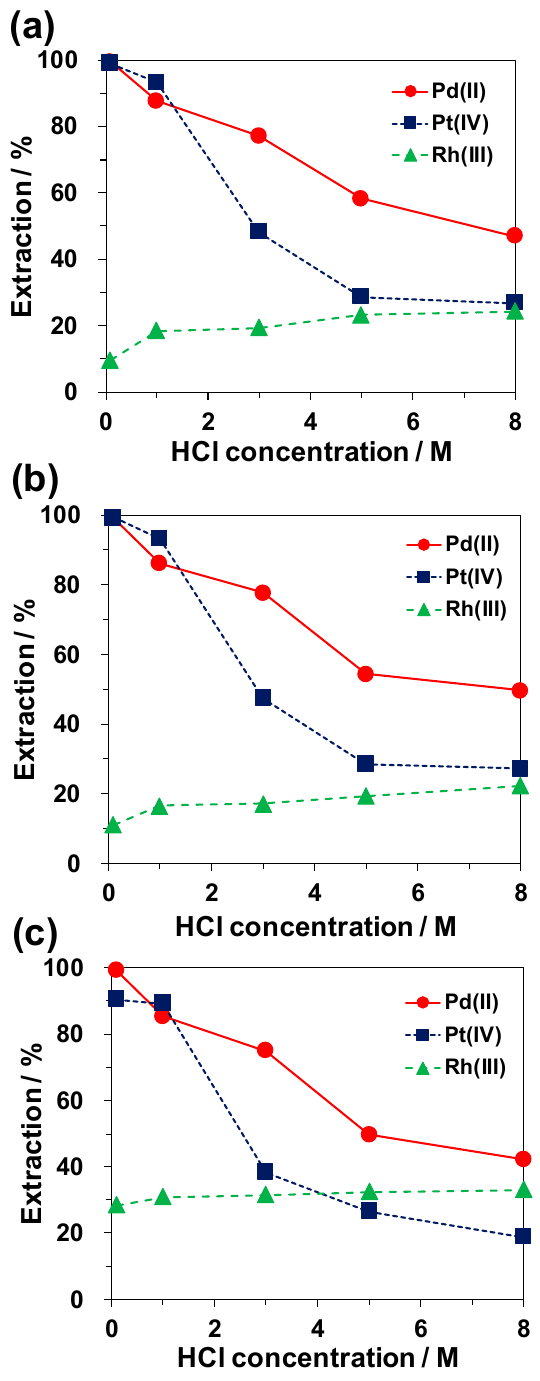
Figure 1. Extraction efficiency of three platinum group metals (PGMs) as a function of HCl concentration by extractants ( a ) 3 , ( b ) 4 , and ( c ) 5 from a single-component solution of Pd(II), Pt(IV), and Rh(III). Contact time = 60 min, [ 3 – 5 ] = 1.0 mM in CHCl 3 , [Pd(II)] = 0.1 mM (10.6 mg/L), [Pt(IV)] = 0.1 mM (19.5 mg/L), [Rh(III)] = 0.1 mM (10.2 mg/L), HCl = 0.1–8.0 M, temperature = 20 ± 1 °C.